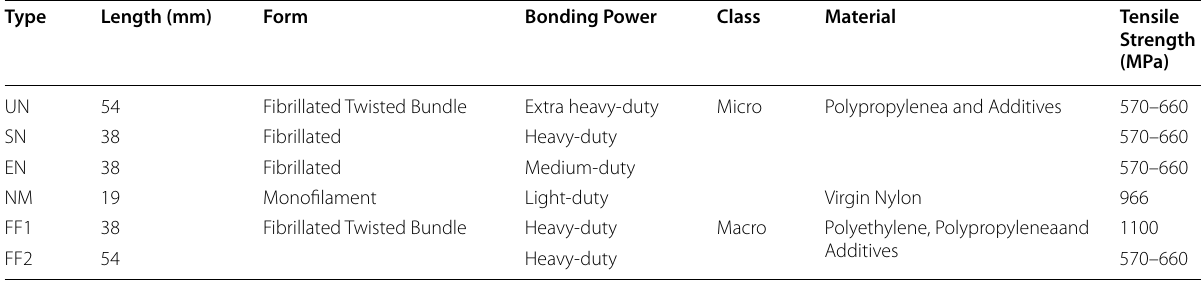
Table 1 FORTA fibers technical data (UN: Ultra-Net, SN: Super-Net, EN: Econo-Net, NM: Nylo-Mono, FF: Ferro) Type